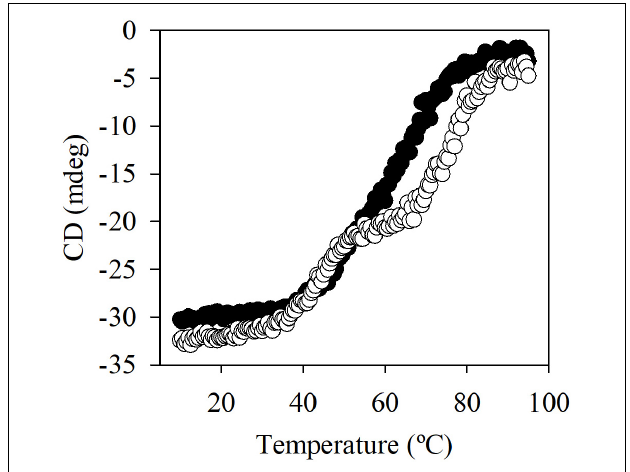
FIGURE 3 | The thermal denaturation curve of Est A 5 (filled circle) and Est A 6 (open circle) at pH 7.0. The datasets were obtained by measuring the ellipticity changes at 220 nm obtained at different temperatures. For raw data see Supplementary Table 2 .